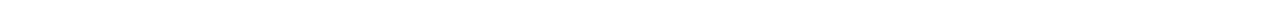
Figure 8 | IL-35 facilitates PDAC cell extravasation and metastasis in vivo via upregulating ICAM1 expression. ( a , b ) DiI-labelled PDAC cells were injected into green fluorescent protein-knockin mice through the portal veins. At the time points of 6 and 24h, animals were killed and livers were sliced. ( a ) Representative images of adhered/arrested tumour cells (white arrow) and extravasated tumour cells (red arrow) in livers are shown ( n ¼ 6 for each group). ( b ) Numbers of adhered/arrested tumour cells and extravasated cells are analysed. ( c – f ) Indicated tumour cells were orthotopically transplanted into the SCID mouse pancreases to develop tumours ( n ¼ 8 for each group). Representative images of the tumours and metastatic sites of livers are shown in c . Hematoxylin and eosin staining images of liver micrometastasis sites are shown in d . The total numbers of visible metastatic lesions in c and invisible